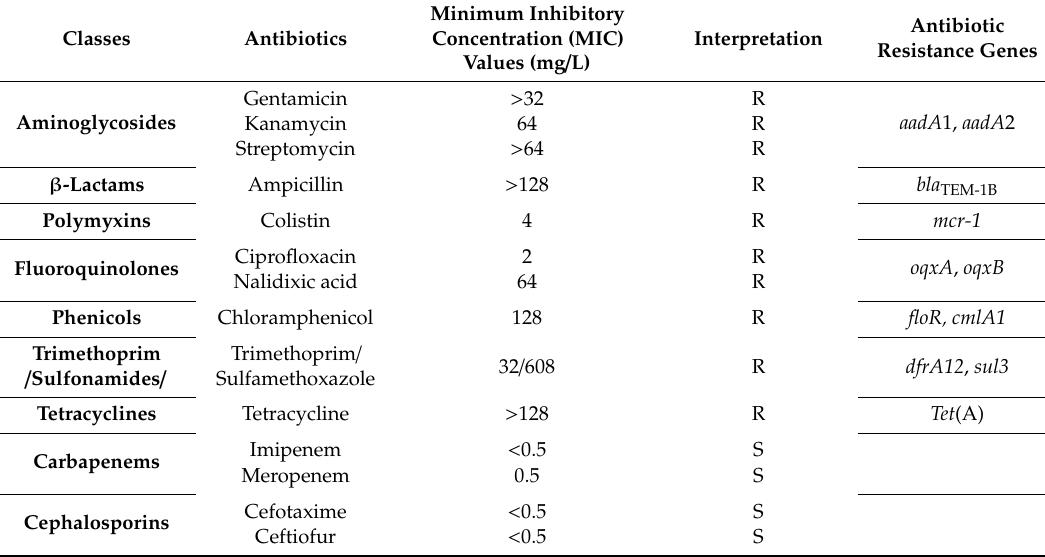
Table 1. Antibiotic phenotype with the corresponding resistance genes of H 2 S-producing E. coli